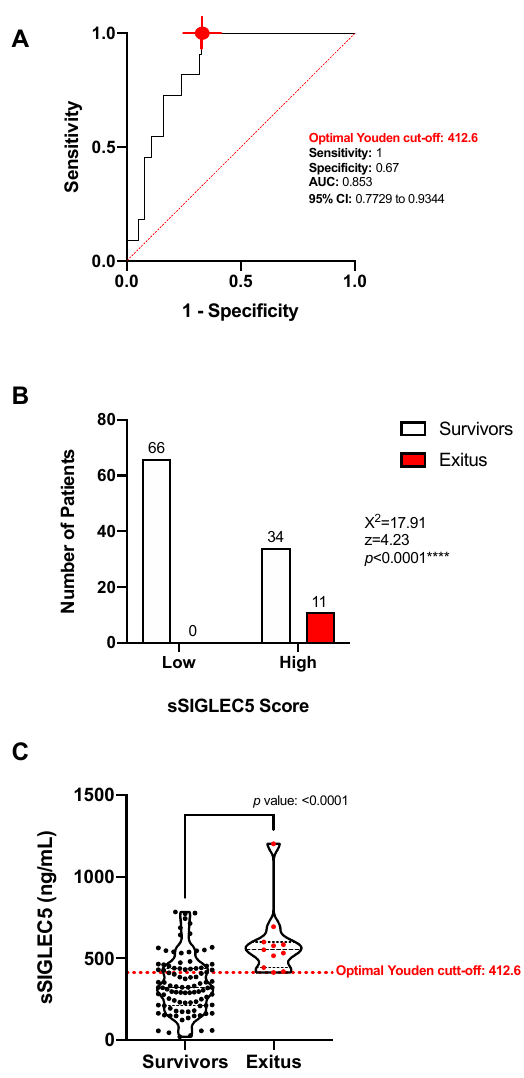
Figure 3. Pre-operative soluble SIGLEC5 (sSIGLEC5) levels predict exitus in patients with colorectal cancer. ( A ) The receiver-operating-characteristic (ROC) curve describing the predictive performance value of plasma sSIGLEC5 for exitus in patients with colorectal cancer ( n = 111) (red line; area under the curve (AUC), 0.853 (95% CI 0.7729 – 0.9344)) is shown. Optimal cut-off, estimated by the Youden index for plasmatic sSIGLEC5 concentration, 412.6 ng/mL (red point shows optimal Youden cut-off specificity and sensitivity values). The ROC curve analysis was performed by Wilson/Brown test, with 95% confidence interval. ( B ) Chart shows how exitus is significantly higher in the sSIGLEC5-high group compared with the sSIGLEC-low group. The contingency table was analyzed with the chi-squared test. ( C ) The sSIGLEC5 levels in plasma in the survivor ( n = 100) and exitus ( n = 11) groups separated by the optimal Youden index (red dashed line) are shown. Differences in sSIGLEC5 levels between survivor or exitus groups were analyzed by Mann–Whitney U test. A p -value < 0.05 was used as the level of significance. **** p <